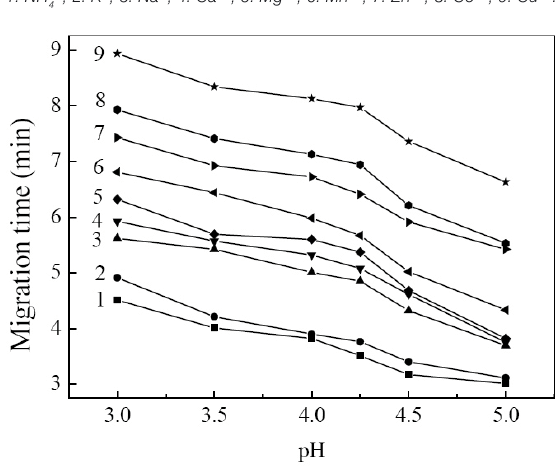
Figure 4. Effect of pH on the separation of inorganic cations.